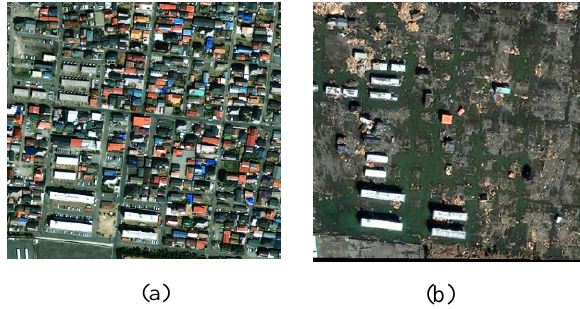
Figure.2 The RGB color images show Ishinomaki area before (a) and after (b) the Tsunami